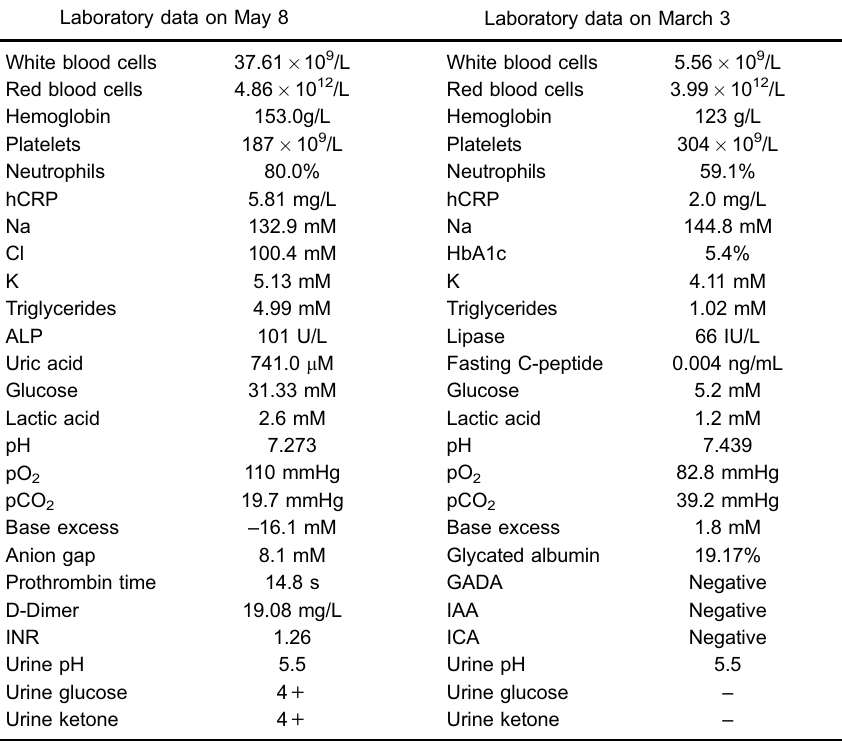
Table 2. Laboratory data of Patient